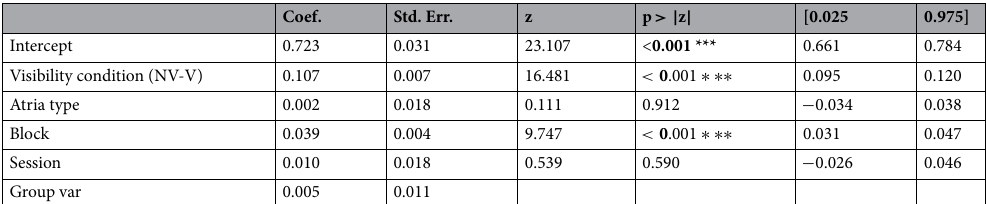
Table 3. Results of the ‘ Average Cosine Similarity ’ Linear mixed effects model regression (LEMR), AvgCosineSimilarity ∼ AtriaType + Block + VisibilityCondition + Session + ( 1 | Participant ) , we denote p-values satisfying the Bonferroni corrected alpha with ***.